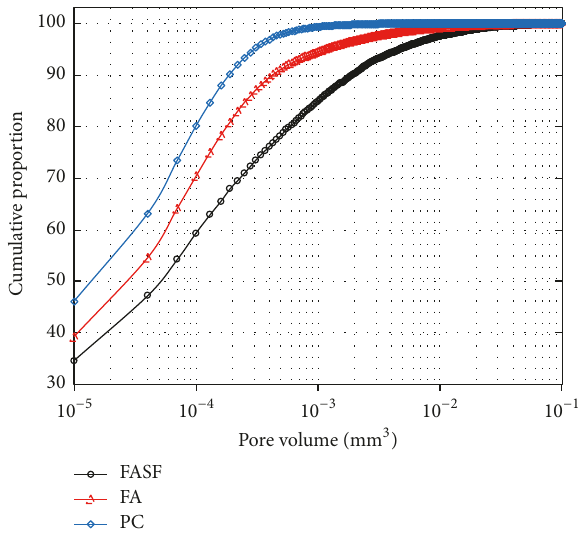
Figure 2: Pore-volume distributions of FASF, FA, and PC samples obtained from micro-CT data.